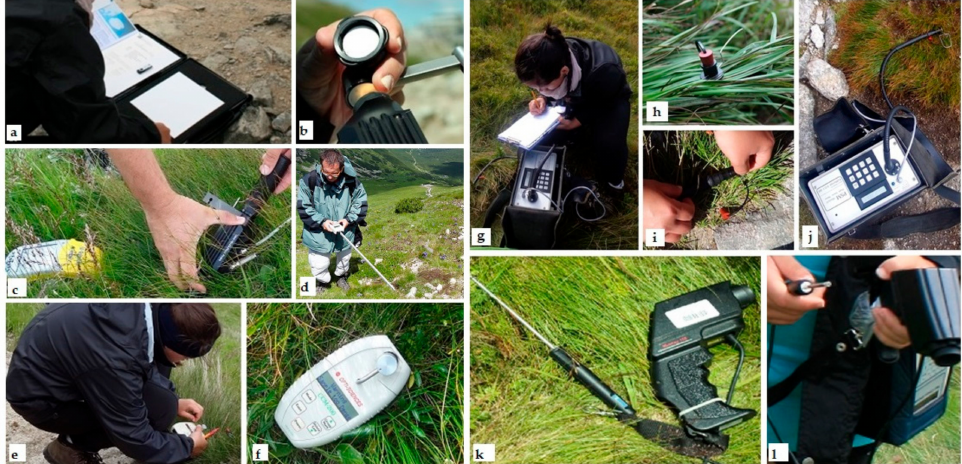
Figure 2. Equipment: ( a ) white SG 33151 Zenith Lite Reflectance Target; ( b ) Leaf clip calibration target of the ASD PlantProbe (P / N A122634); ( c ) spectrometric measurements using ASD FieldSpec 3, ASD PlantProbe and location by GPS Trimble GeoXT; ( d ) AccuPAR PAR-80 measurements; ( e , f ) Chlorophyll Content Meter CCM200; ( g – j ) fluorescence measurements using Plant Stress Meter (PSM Mark II) with LeafClip; ( k , l ) Pyrometer iRtecMiniRay-100 (Photography taken by Bogdan Zagajewski and Marlena